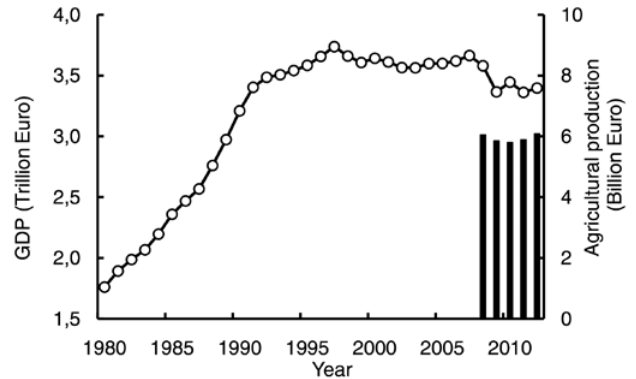
Fig. 1 - Figures for the GDP (1980-2012) and agricultural production (2008-2012) in Japan calculated using the IMF World Econom- ic Outlook Database (2013) and statistics released by MAFF (2013),